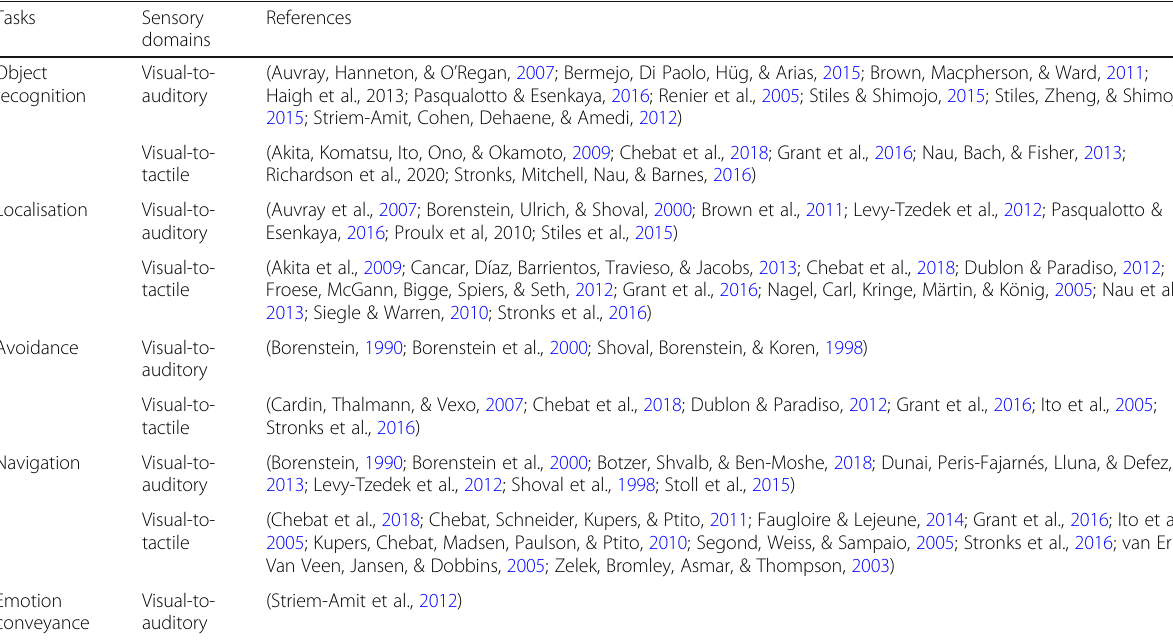
Table 2 Table with key references for a variety of cognitive tasks successfully completed by visual-to-tactile or visual-to-auditory sensory substitution techniques